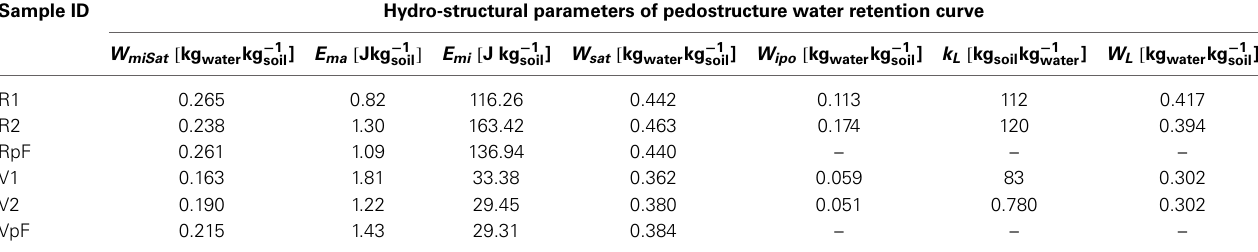
Table 3 | Values of parameters of the pedostructural water retention curve for Rodah and Versailles soils. Sample ID Hydro-structural parameters of pedostructure water retention